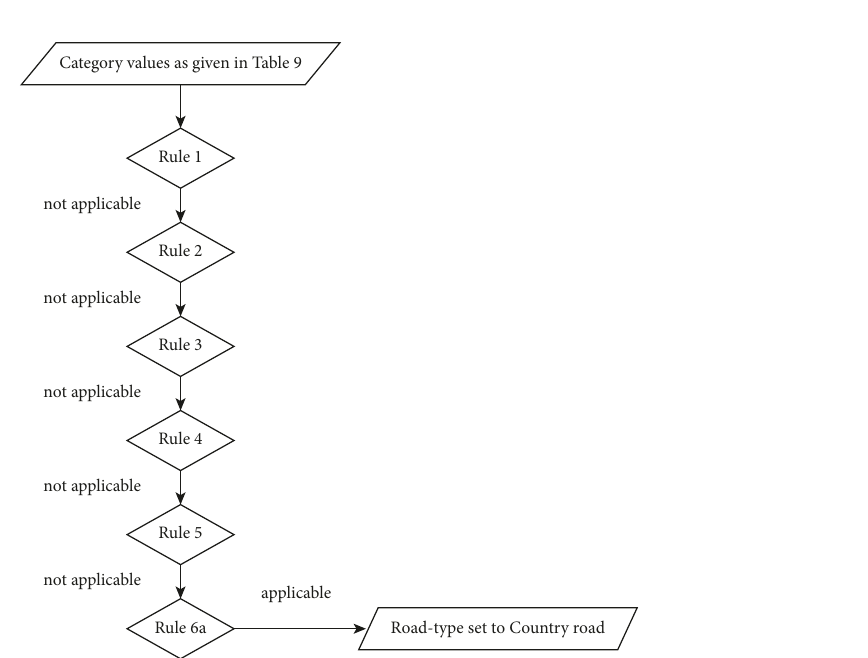
Figure 8: The steps through which the road-type decision is reached for road location shown in Figure 5. Table 19: The road-type composition of the training road data. Total length of roads within built-up areas 76 (km) Total length of country roads 91 Total length of expressway 54 Total length of motorways 58 Total road length 279 Table 20: Hand-of-traffic composition of training road data. Total length of roads with right-hand traffic (recorded 203 within Austria, Germany, and Hungary) (km) Total length of roads with left-hand traffic (recorded 91 within the UK) Total road length